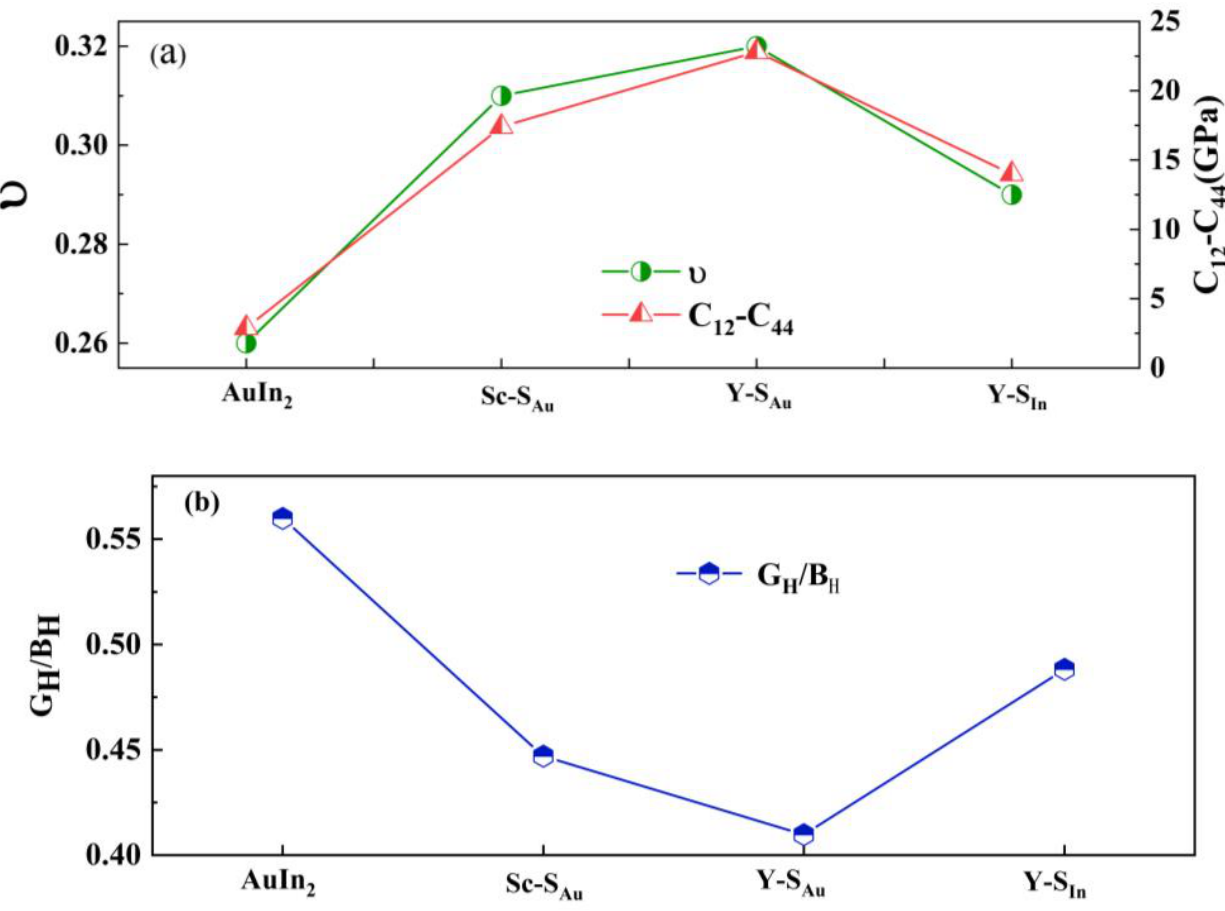
Figure 2. Variation of ν and C 12 − C 44 ( a ), G H /B H ( b ) of AuIn 2 and doped system. Table 4. Calculated elastic anisotropic indexes ( A U , A comp , A shear , and A 1 ) of AuIn 2 and doped systems. Phase A U A comp A